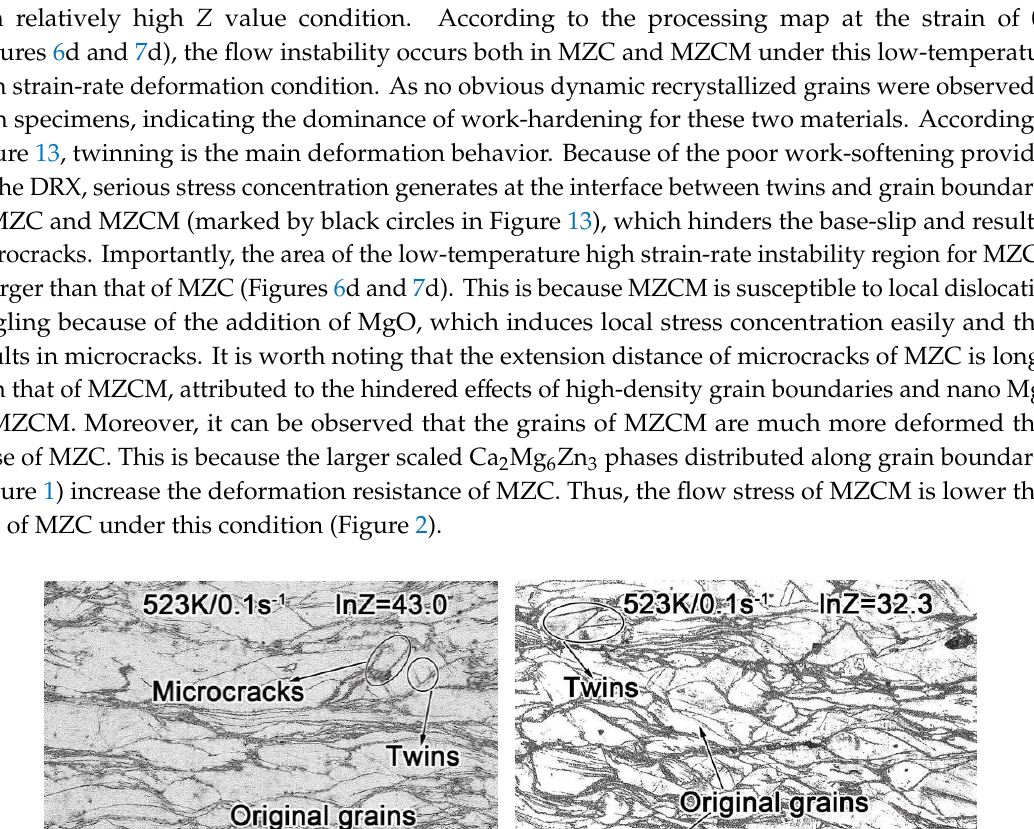
Figure 13. Microstructures of MZC ( a ) and MZCM ( b ) deformed at 523 K/0.1 s − 1 .